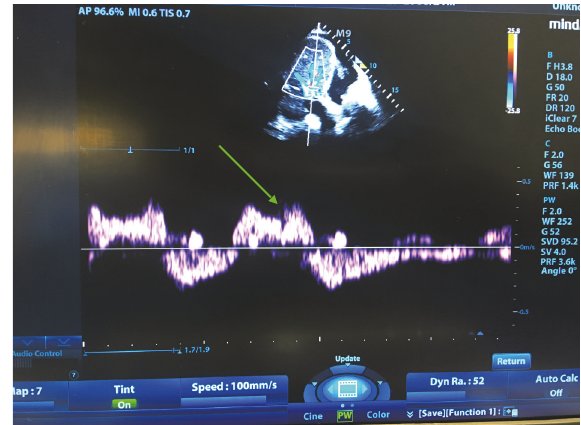
Figure 4: Hepatic vein Doppler exam on day 1. Evidence of systolic flow reversal (green arrow).